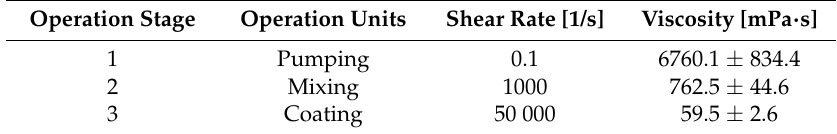
Table 3. Viscosity of chitosan, shear rates, corresponding operation stages and units ( n = 4). Operation